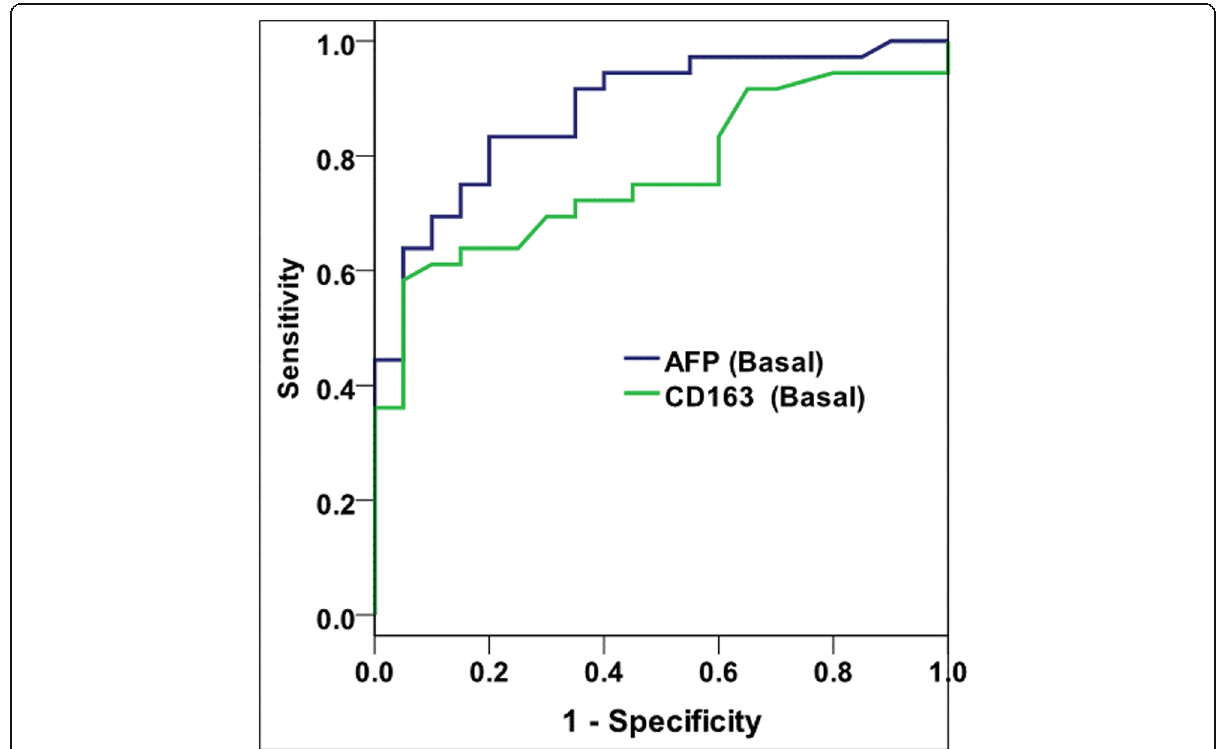
Fig. 1 ROC curve showing comparison of the diagnostic performance of serum sCD163 and AFP for discriminating HCC group from liver cirrhosis group